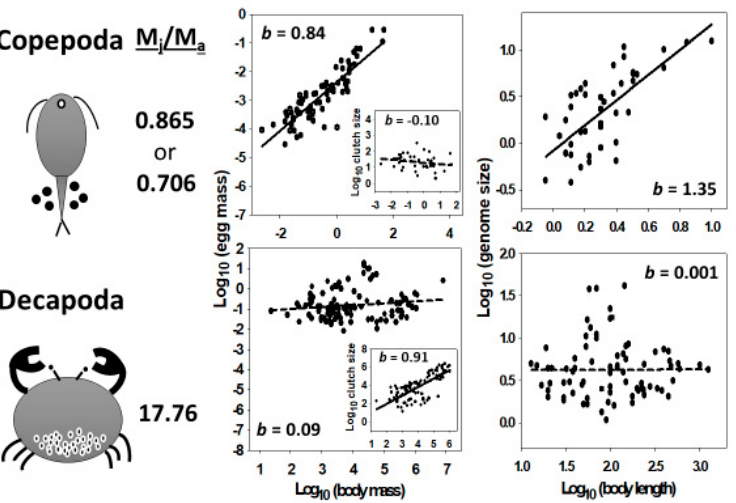
Figure 7. Body-mass scaling of egg mass and number per clutch (left-hand graphs) (data from [101]), and body-length scaling of genome size (right-hand graphs) (data from [57]) in copepods and decapods having different ratios of juvenile/adult mortality (M J /M A ) (data from Table A3). For copepods, the top ratio is based on M J for nauplii, whereas the bottom ratio is based on M J for copepodids. The scaling exponent (slope, b ) is indicated for each relationship. Hypothetical effects of M J /M A on the observed scaling relationships are discussed in Section 4.7.1 (also see [101]).